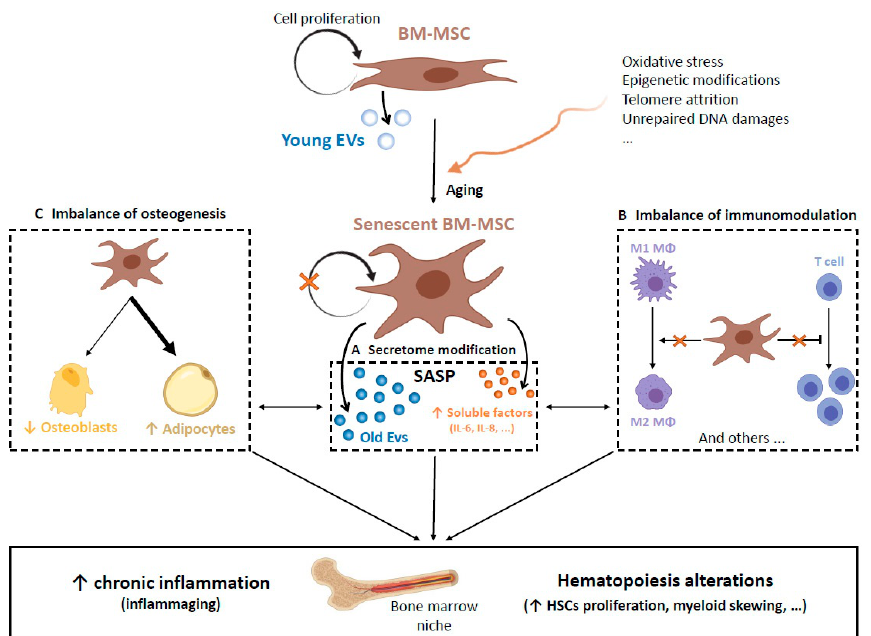
Figure 1. With aging, several factors induce the senescence of bone marrow mesenchymal stromal cells (BM-MSCs) that accumulate inside the bone marrow (BM) niche. ( A ) The senescent BM-MSCs adopt the senescent-associated secretory phenotype (SASP) enriched in particular with proinflammatory cytokines, and their extracellular vesicle (EV) morphology and content are strongly modified (see Section 2.1). ( B ) The immunomodulatory properties of aged BM-MSCs are im- paired. For example, their ability to promote macrophage (M Φ ) polarization into the M2 phenotype and their capacity to inhibit T lymphocyte proliferation are reduced (see Section 2.2). ( C ) An imbalance between osteogenesis and adipogenesis occurs, leading to a progressive replacement of bone by fat (see Section 2.3). All of these processes are closely intercon- nected and can lead to the establishment of low-grade chronic inflammation and hematopoiesis alterations (Figure created with